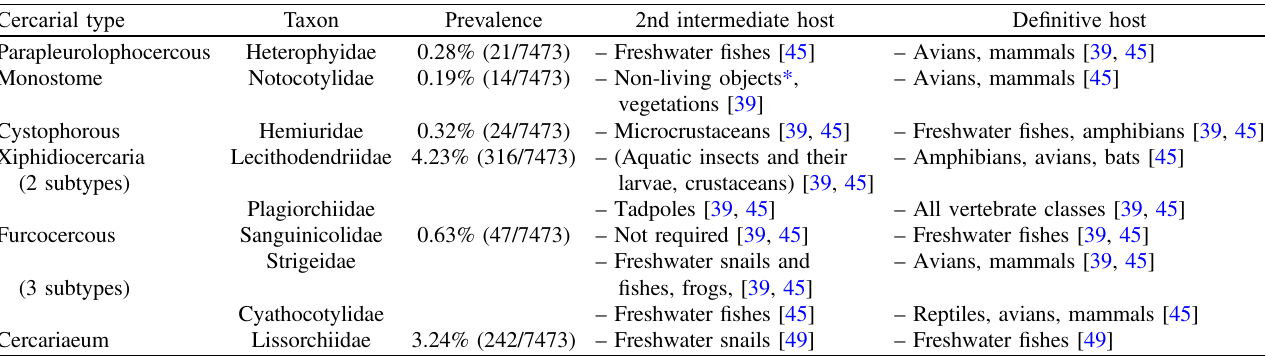
Table 3. Prevalence of other cercarial types detected in Bithynia siamensis siamensis snails in this study.